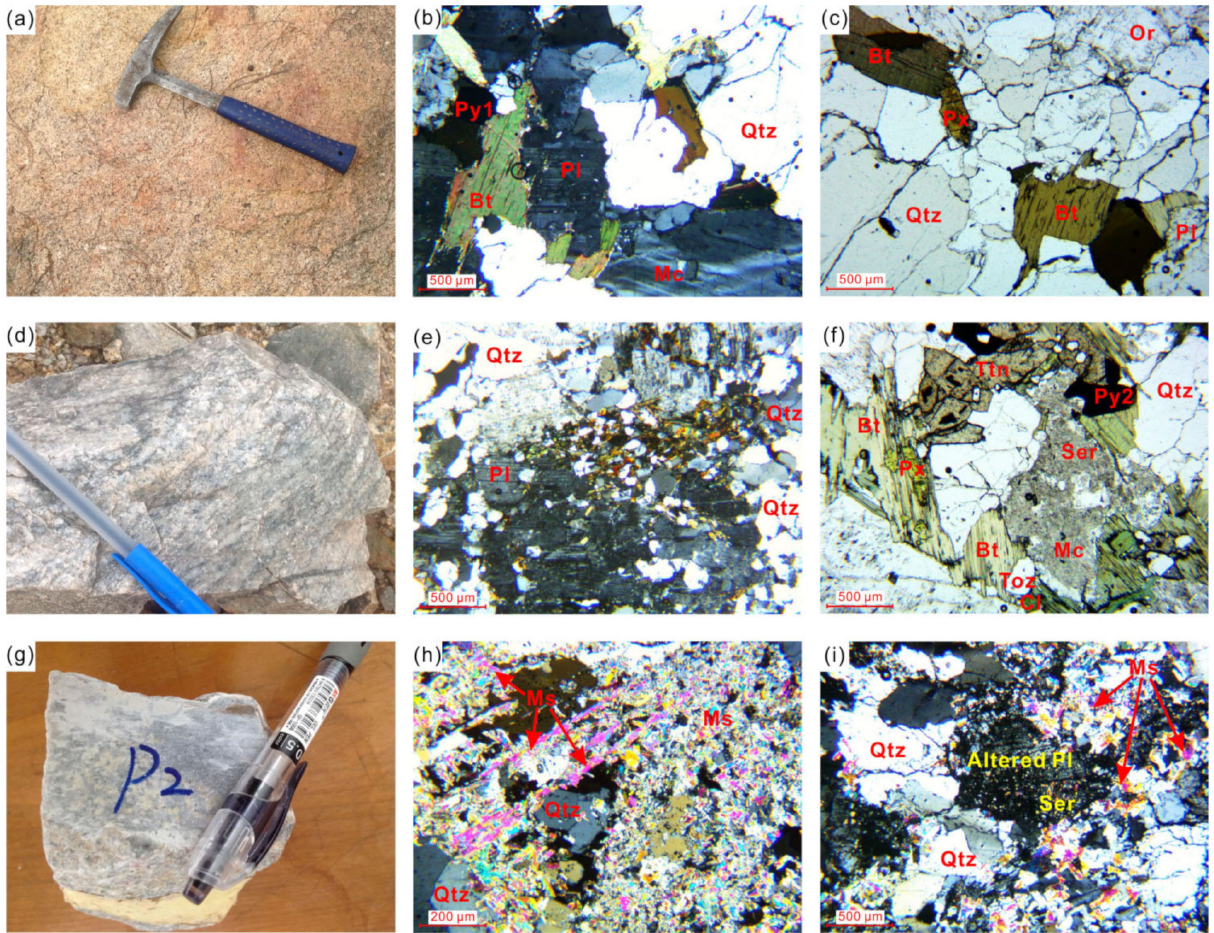
Figure 4. Photographs of hand specimens and microphotographs of Older Granite, greisen wall-rocks, and greisenized granite from the Gindi Akwati deposit. ( a – c ) least altered Older Granite; ( d – f ) greisen wall-rocks; ( g – i ) greisenized granite. Bt = biotite, Cl = chlorite, Mc = microcline, Ms = muscovite, Or = orthoclase, Pl = plagioclase, Px = pyroxene, Py = pyrite, Qtz = quartz, Ser = sericite, Toz = topaz, Ttn =